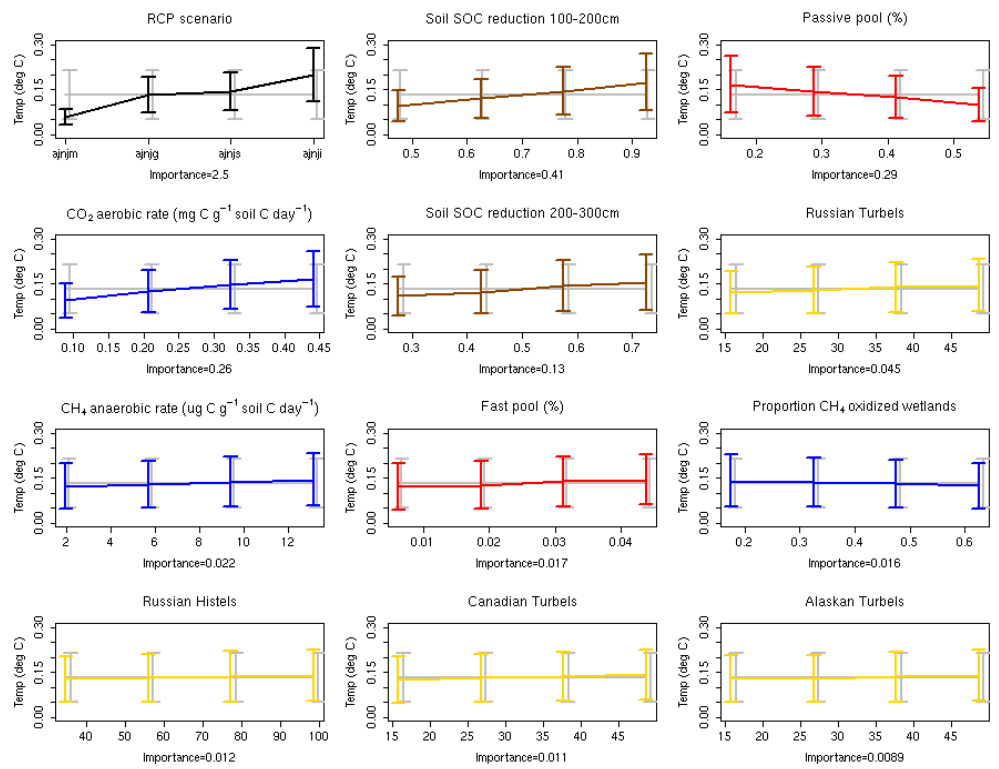
Figure 9. Sensitivity of the Monte Carlo simulations to the most important model parameters/processes. The grey lines represent the mean and standard deviation of the whole ensemble and the coloured lines the mean and standard deviation sampled around each parameter value. The parameters/processes are sorted in order of decreasing importance.